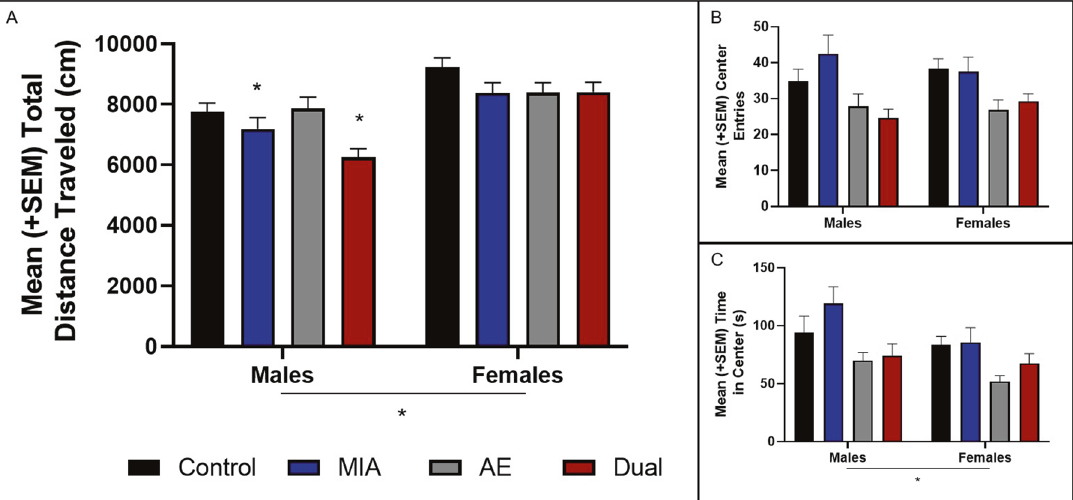
Fig. 4 The impact of MIA and AE on offspring locomotor behavior. A MIA reduced total distance traveled in locomotor response to novelty task in male rats ( p < 0.05). Female rats overall moved more than male rats ( p < 0.05; n = 9 – 11/group/sex from 8 dams). B MIA and/or AE did not impact the number of center entries; or C the time spent in the center ( p > 0.05). Overall, female rats spent less time in the center zone compared to male rats ( p < 0.05).